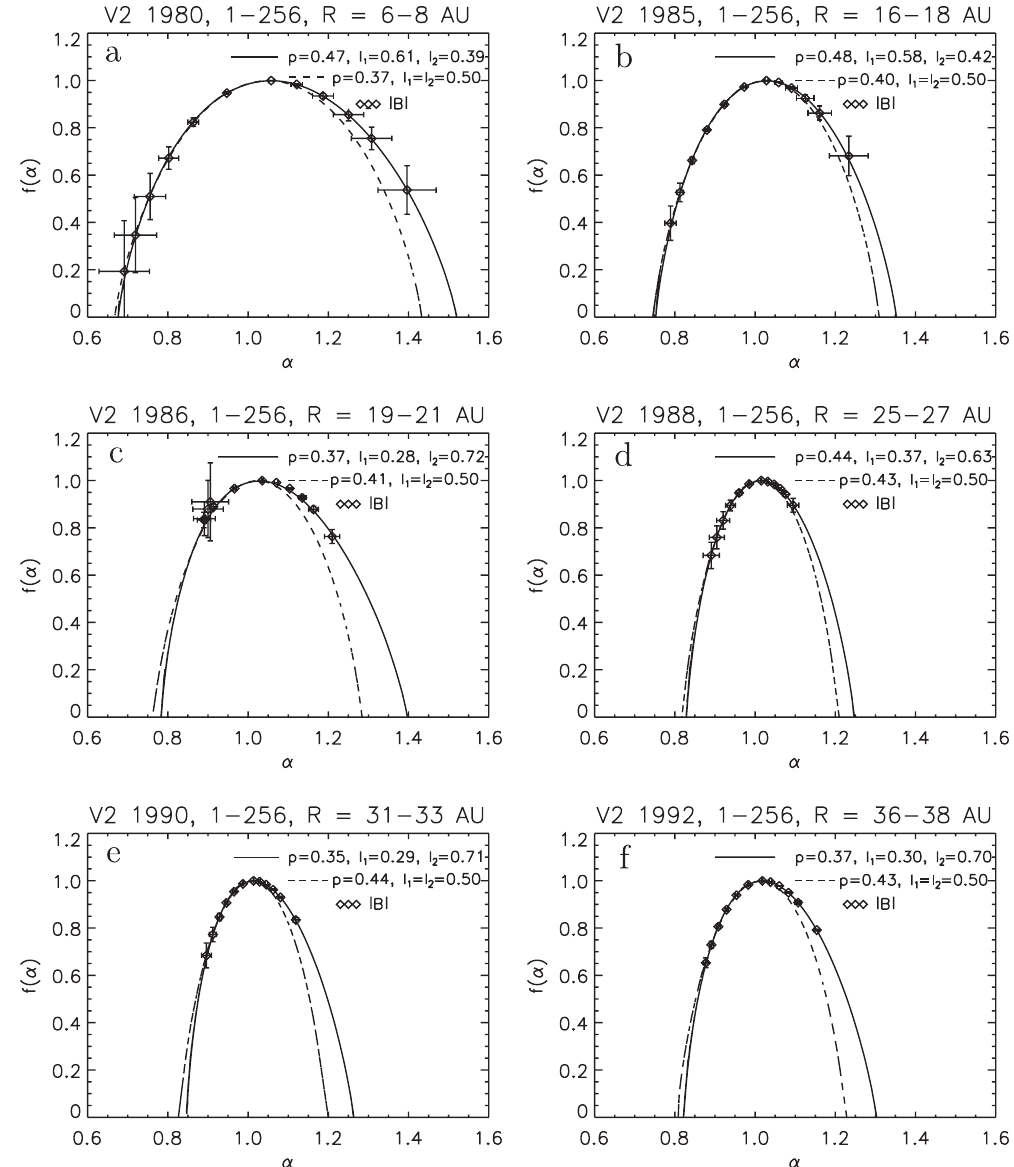
Fig. 3. The singularity spectrum f (α) as a function of a singularity strength α . The values are calculated for the weighted two-scale (continuous lines) model and the usual one-scale (dashed lines) p model with the parameters fitted using the magnetic fields (diamonds) measured by Voyager 2 in the relatively near heliosphere (within planetary orbits) at (a) 6–8AU, (b) 16–18AU, (c) 19–21AU, (d) 25– 27AU, (e) 31–33AU, and (f) 36–38AU,